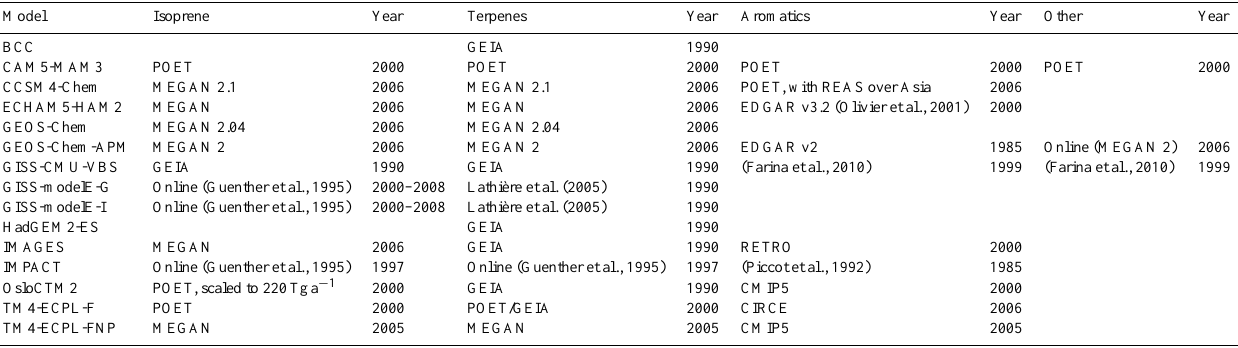
Table 5. SOA precursor emissions adopted by the models. Models that do not calculate semi-volatile SOA have been omitted. Model